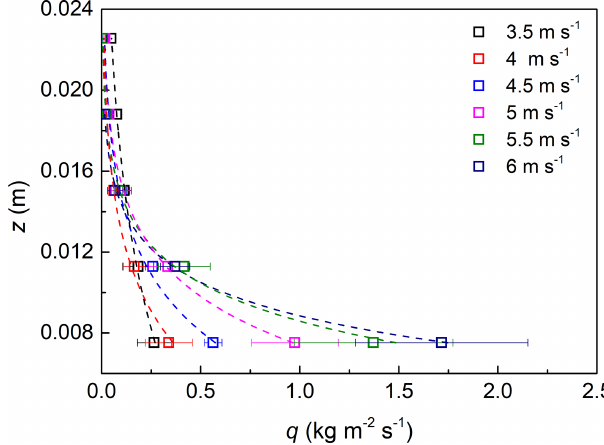
Figure 5. Collection efficiency E (in blue) and snow transport rate Q (in red) under different non-dimensional wind speeds ˜ u . X repre- sents the distance from the snow particle feeding point to the mass collection pits where the cornice grows. Lines are for ring wind tunnel experiments, and hollow scatters are for N&K86. N&K86 represents the experiment results of Naito and Kobayashi